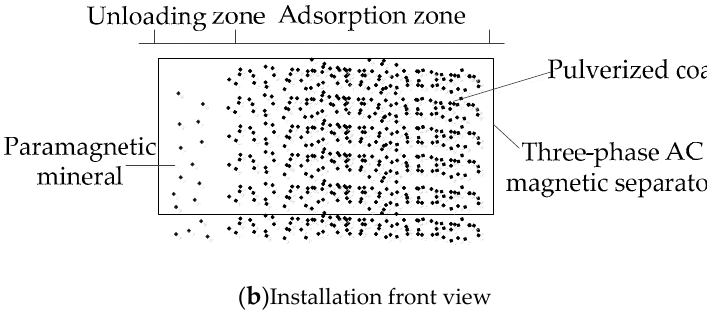
Figure 2. Installation diagram of the three ‐ phase ac magnetic separator.